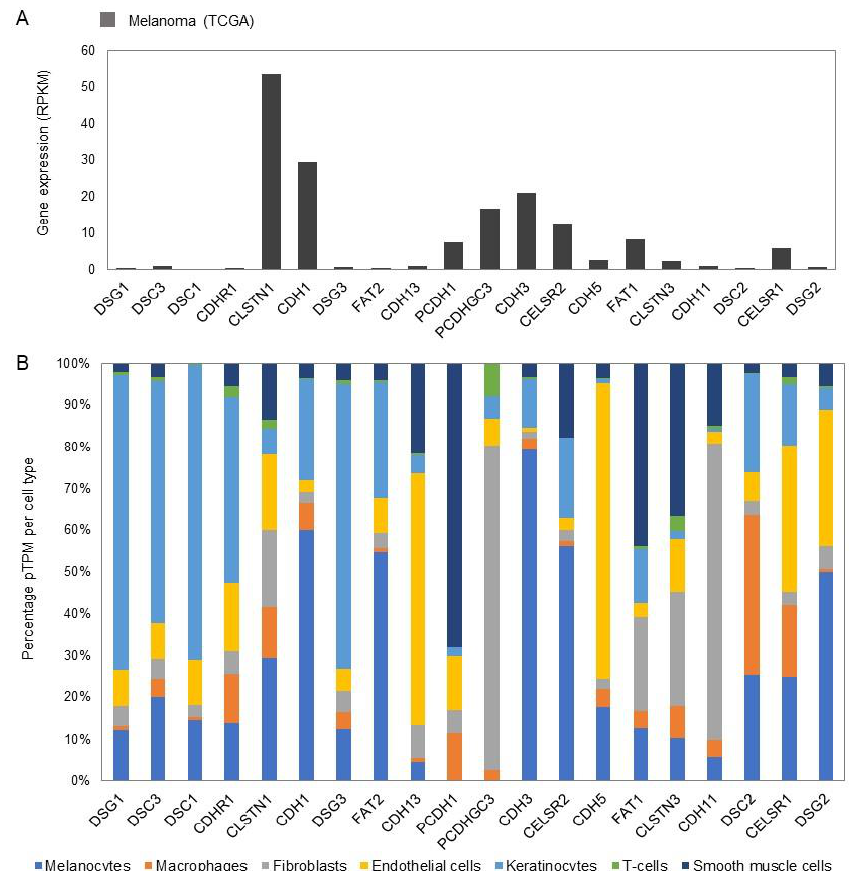
Figure 2. Gene expression of cadherins in melanoma cells and different cell types of healthy human skin. ( A ) Expression of cadherin genes in metastatic melanoma cells from single-cell RNA-seq experiments (Tirosh et al., 2016). ( B ) Expression of cadherin genes in different cell types of healthy human skin from single-cell RNA-seq experiments (Sole-Boldo et al., 2020), where expression values of clusters of similar cell types were merged. See also Table S1.